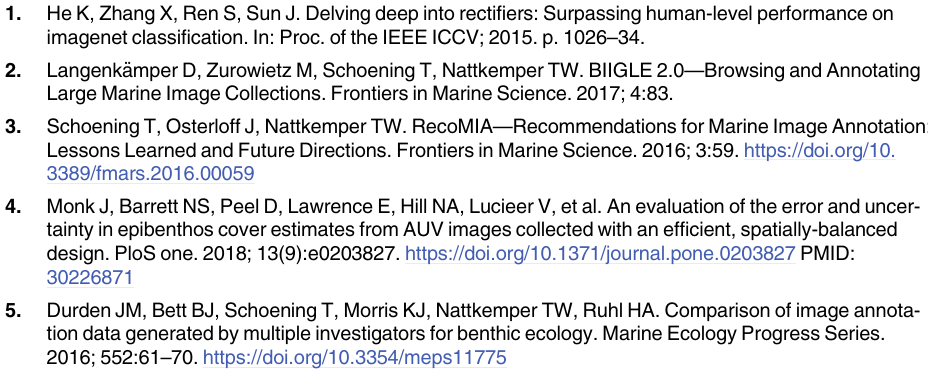
S2 Fig. The volume label review tool Volare of BIIGLE 2.0. The currently focused circle annotation is highlighted at the center of the vieport. Once the human observer finished manipulating the position and size of the circle, the viewport automatically jumps to the next